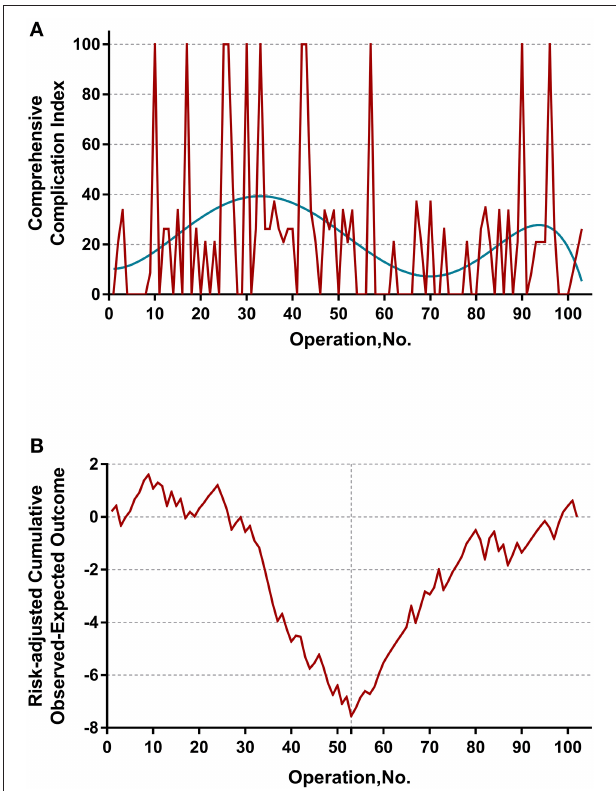
FIGURE 2 | (A) Evolution of postoperative complications regarding Comprehensive Complication Index (CCI) was plotted against cases of ELRAs performed. The blue curve represents the curve of best fit for the plots. A visual inspection showed the first peak of fitted curve around case 33 and the second peak around case 95. (B) RA-CUSUM analysis of major postoperative morbidity (CCI > 26) for the difference between the cumulative expected outcome and the actual observed outcome. A multivariable logistic regression model for major postoperative morbidity was constructed to calculate the expected outcome. Every operation is plotted from left to right: the line ascends for avoiding postoperative major morbidity, whereas the line descends for encountering postoperative major morbidity. Visual inspection shows a learning curve of 55